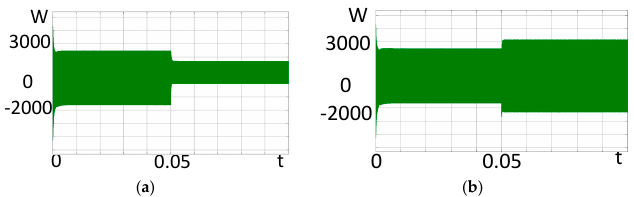
Figure 9. The waveform of the transient power of the low voltage side of the transformer. ( a ) Optimal mode; ( b ) Traditional mode.